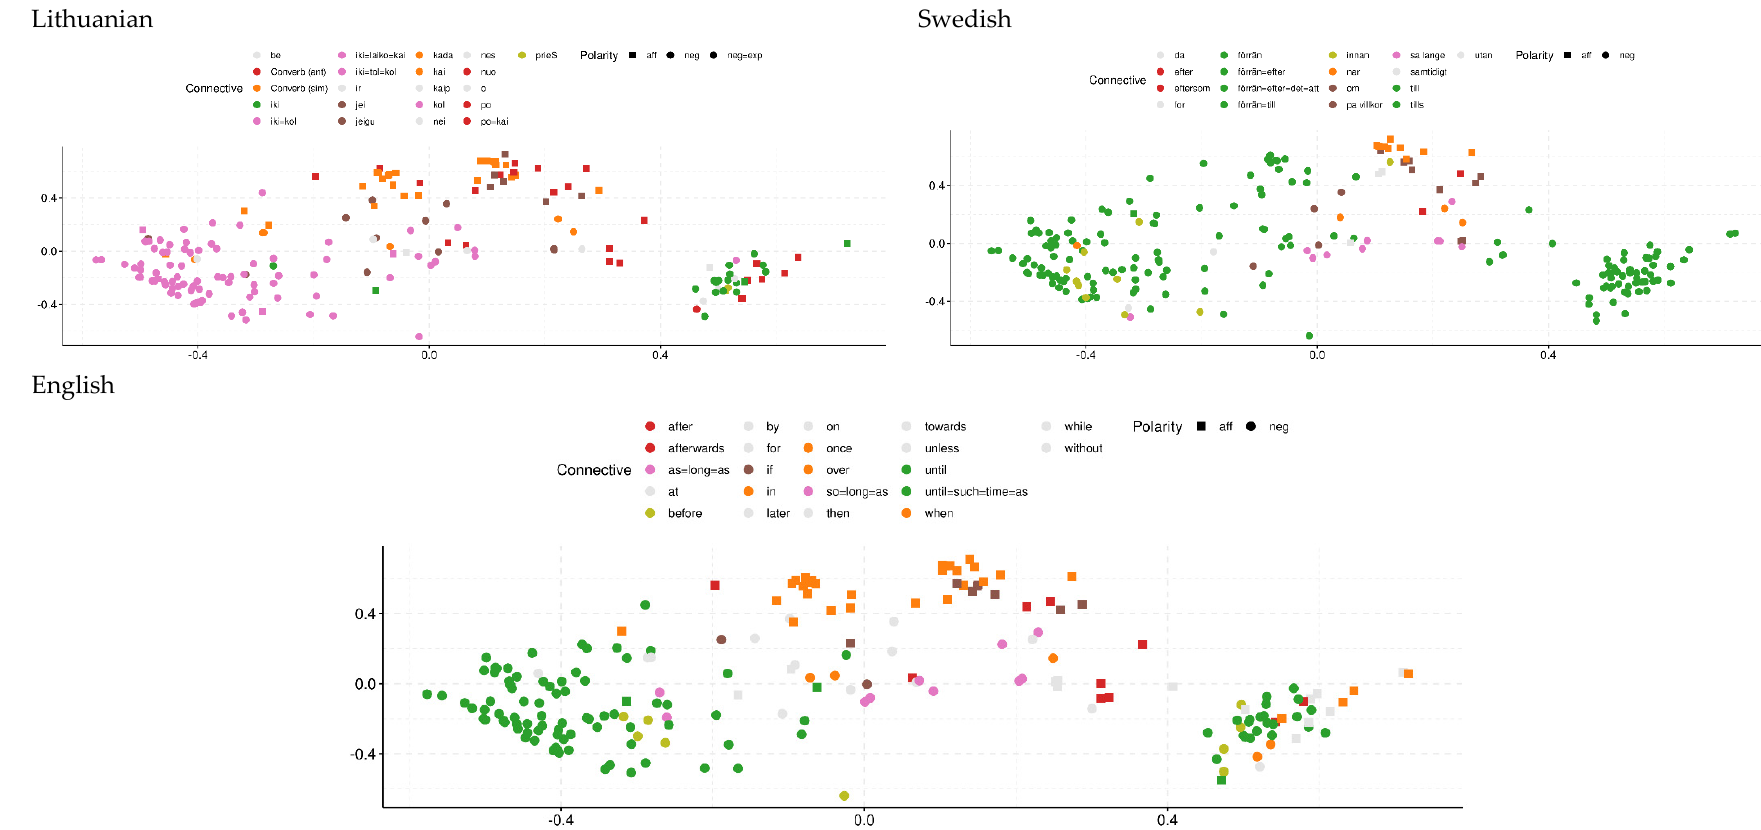
Figure 2. MDS map of connectives and polarity.